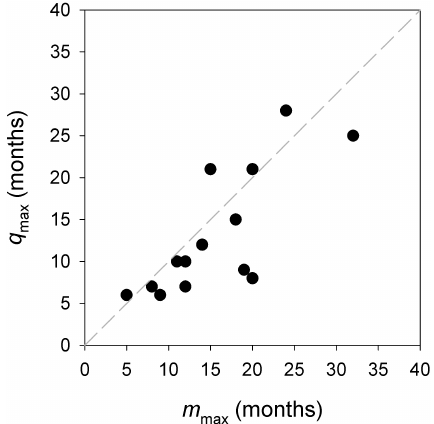
Fig. 10. Plot of the SPI precipitation accumulation period, q max , against autocorrelation range, m max , associated with the maximum cross-correlation between SGI and SPI for all study sites. A 1:1 line is shown for reference. Note the sites at Dalton Holme and Little Bucket Farm have identical positions in this